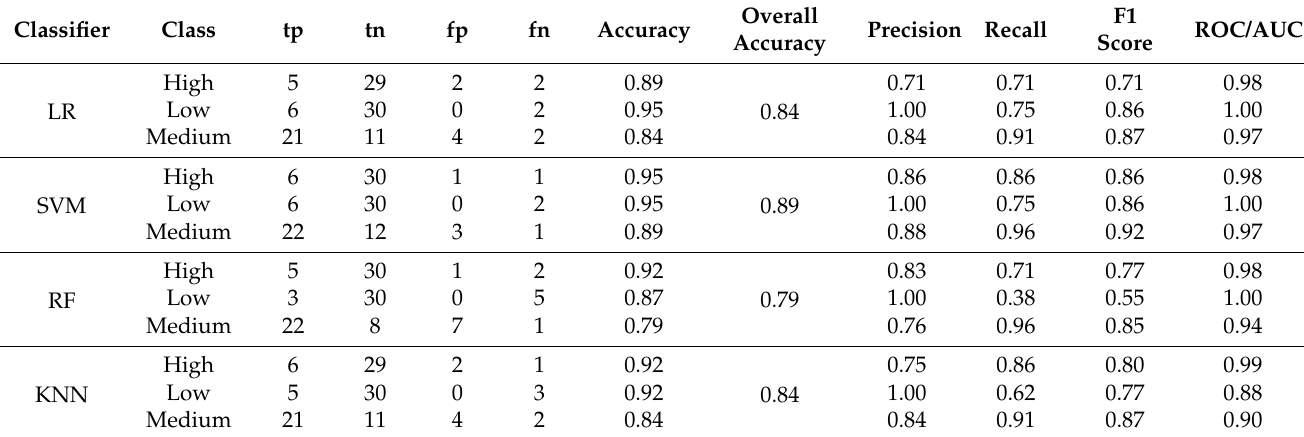
Table 14. Set of metrics of the unbalanced models (testing